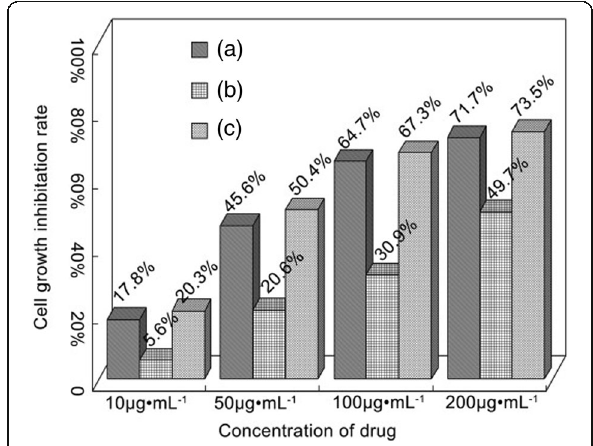
Fig. 7 Anticancer activities to human hepatocellular carcinoma cell SMMC-7721 line cell in vitro. a Cisplatin. b Cis -DIDP. c Cis